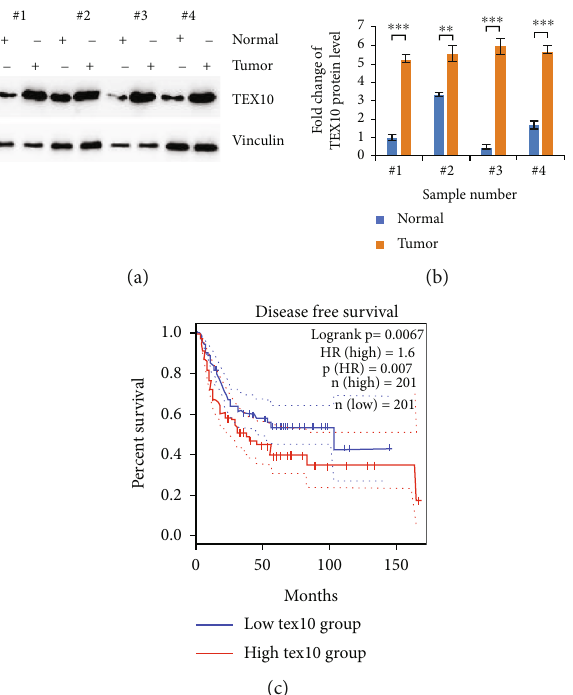
Figure 1: Identi fi cation of TEX10 related to DFS in urinary bladder carcinoma. (a, b) Four pairs of urinary bladder carcinoma tissue and nearby general tissues underwent immunoblotting investigation with the suggested antibodies. Shown is the mean ± SEM . ∗ P < 0 : 05 ; ∗∗ < 0.01; ∗∗∗ < 0.001, Student ’ s t -test. (c) Kaplan-Meier curves of DFS for 402 urinary bladder carcinoma patients of TCGA by adopting GEPIA online website under great or small TEX10 expressing